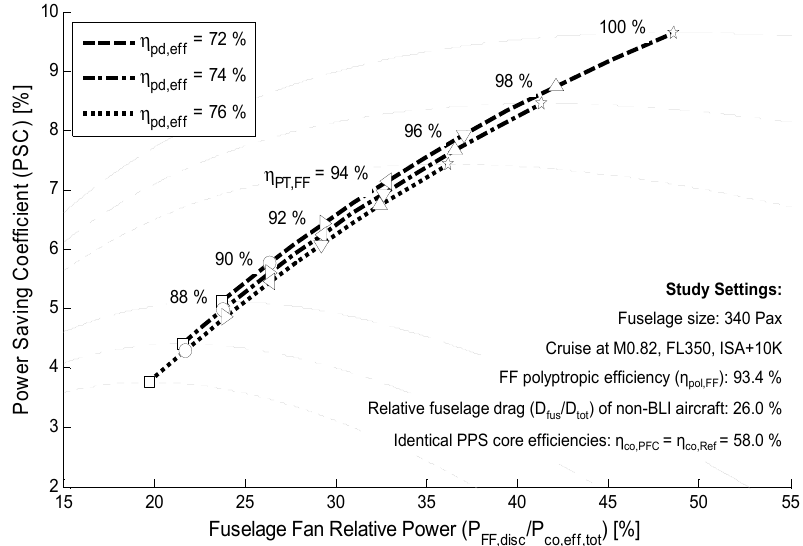
Figure 32. Identification of optimum power savings and corresponding FF cruise power settings for combinations of power train and non-BLI propulsive device efficiencies.